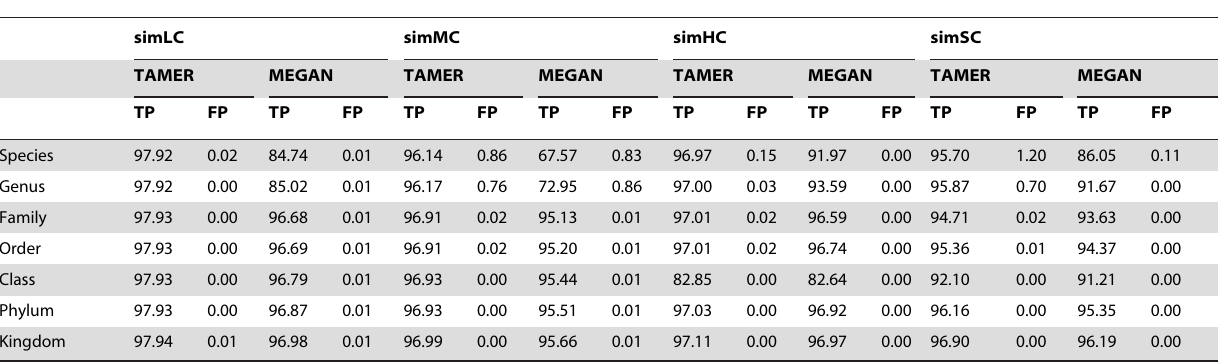
Table 1. Results for simulation study 1 with average read length o1 100